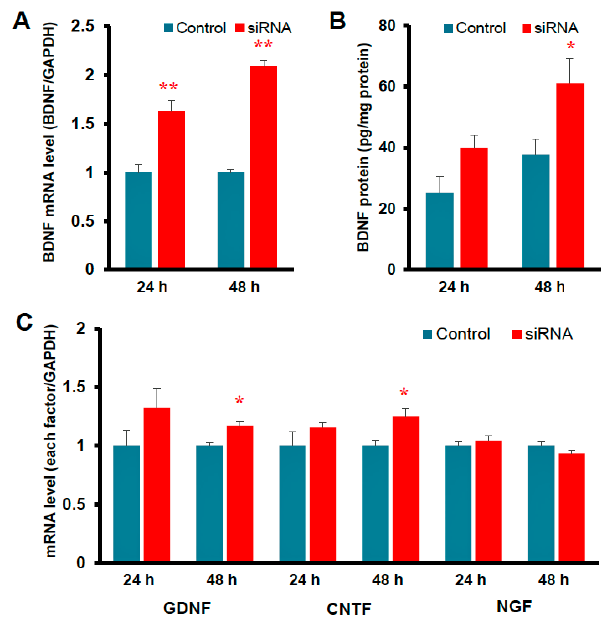
Figure 4. Effects of Kir4.1 knockdown (down-regulation) by the transfection of Kir4.1 siRNA on the expression of BDNF and other neurotrophic factors in astrocytes. ( A ) Effects on BDNF mRNA and ( B ) protein expression. ( C ) Effects on mRNA expression of other neurotrophic factors (GDNF, CNTF, and NGF). The mRNA and protein levels were analyzed at 24 h or 48 h after the transfection of Kir4.1 siRNA. * p < 0.05; ** p < 0.01. Graphs are quoted from Front. Mol. Neurosci . 2017, 10, 408 [9].